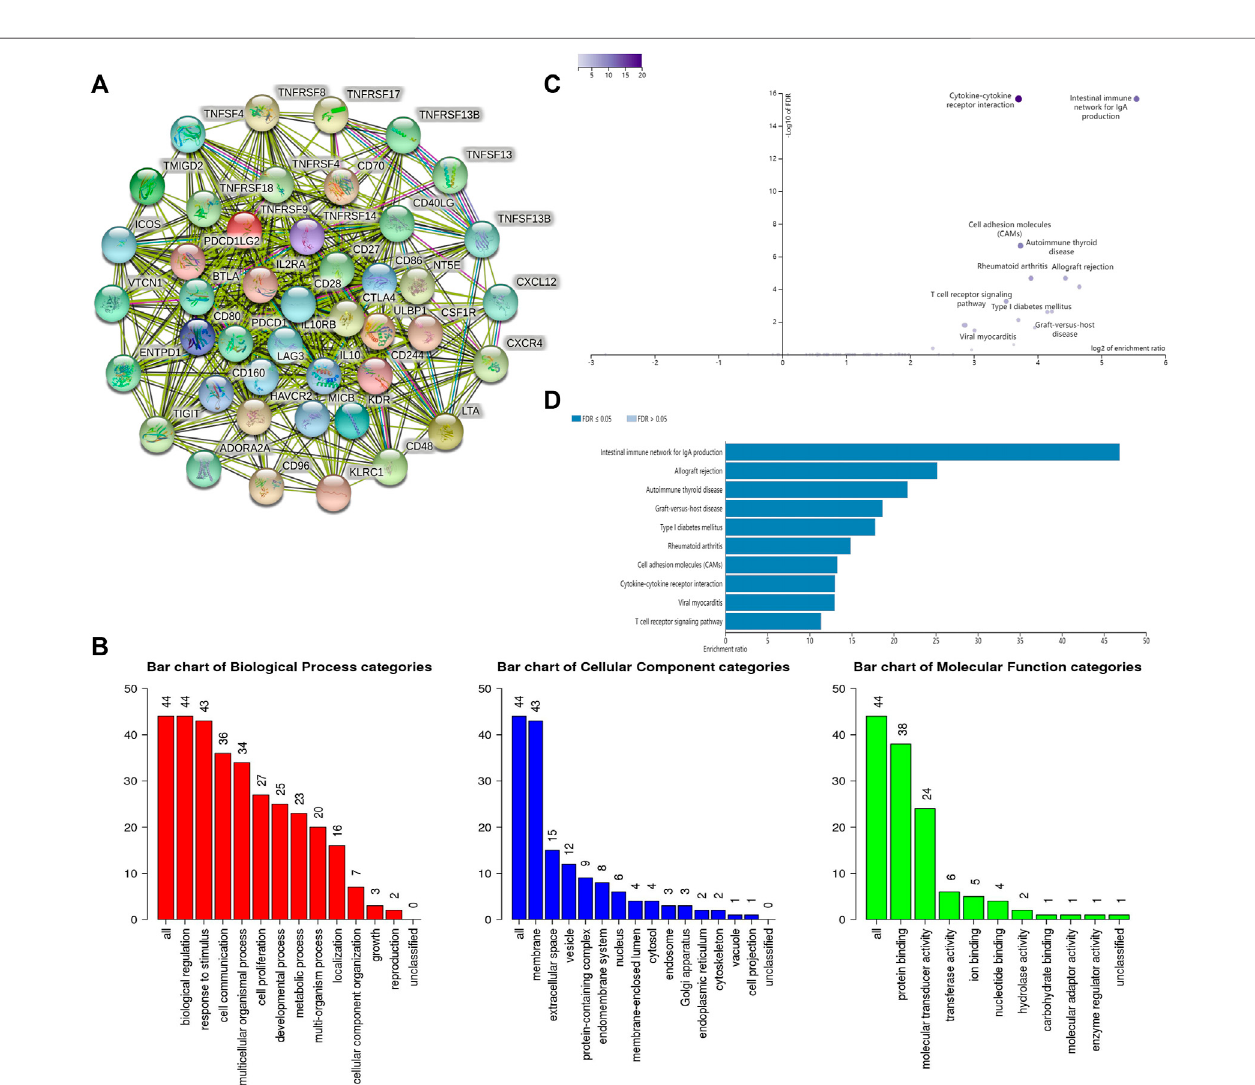
FIGURE5| AnalysisofSLC6A8-associated immunomodulators. (A) Protein interaction network ofSLC6A8-associatedimmunomodulators inn LUAD asmapped using the STRING database. (B) GO and (C , D) KEGG analysis of SLC6A8- associated immunomodulators in LUAD using the WebGestalt website.